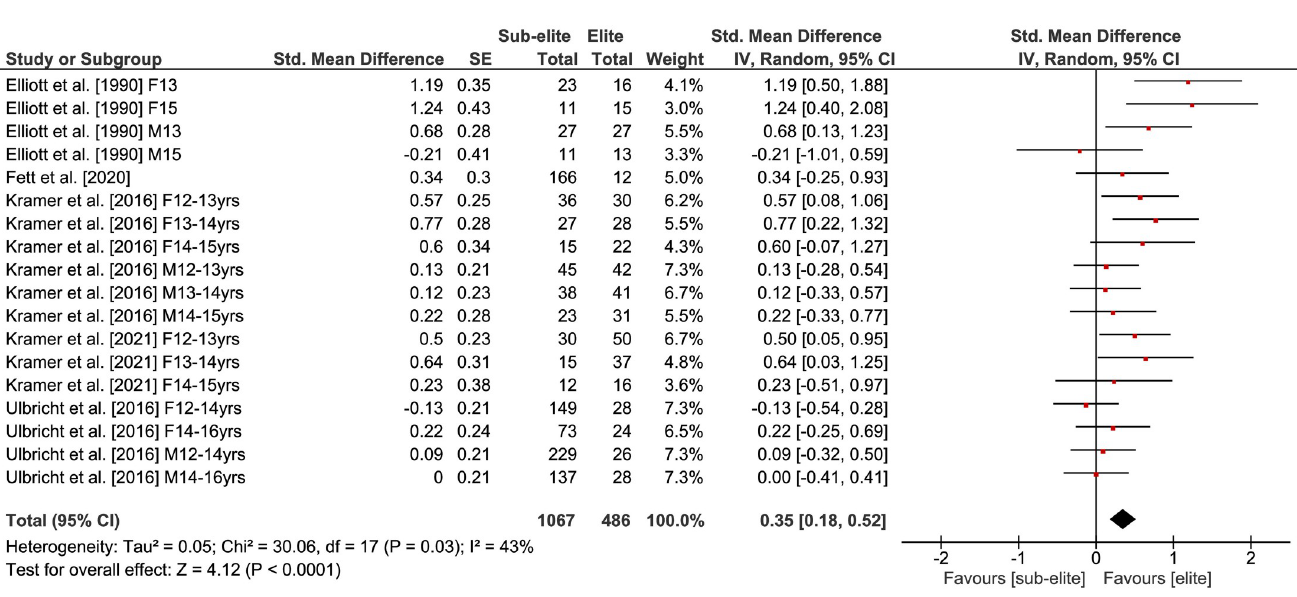
Fig 5. Differences in measures of speed by competition level (i.e., elite vs. sub-elite tennis players). CI = confidence interval, df = degrees of freedom, SE = standard error, IV = inverse variance. Table 4. Differences in measures of physical fitness and stroke performance between players with different com- petition level (i.e., elite vs. sub-elite tennis players) by age group. Measure